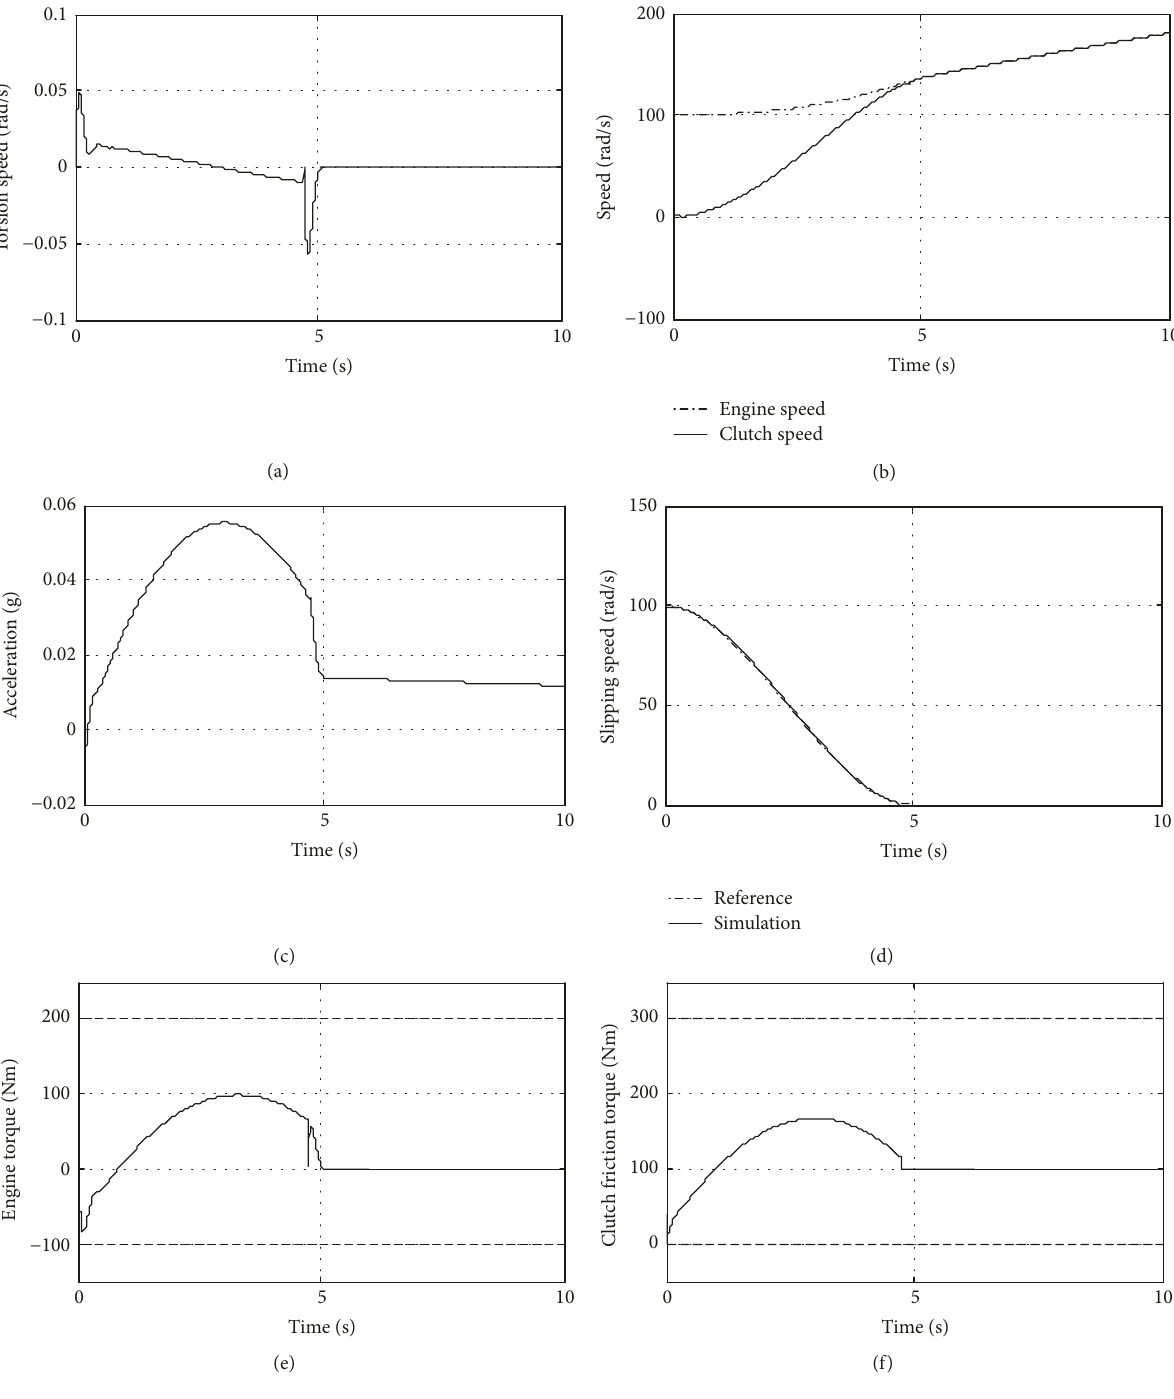
Figure 10: M3 maneuver simulation